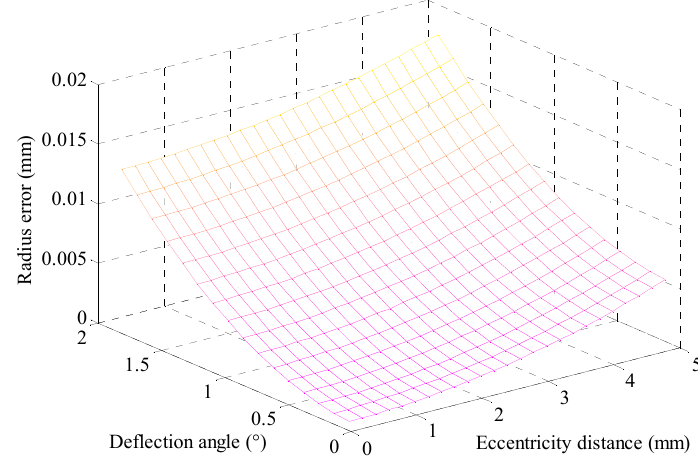
Figure 9. The radius error coursed by the relative position of the rod.